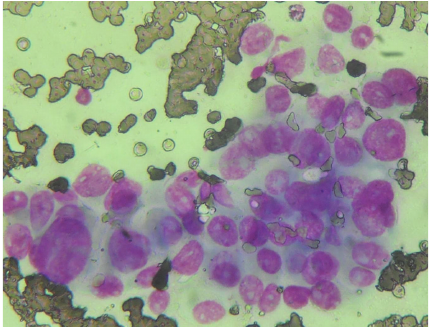
Figure 4: Smear shows malignant ductal epithelial cells arranged in sheets discretely. The cells are large showing pleomorphic nuclei with prominent nucleoli and ample dense greyish cytoplasm (H&E stain